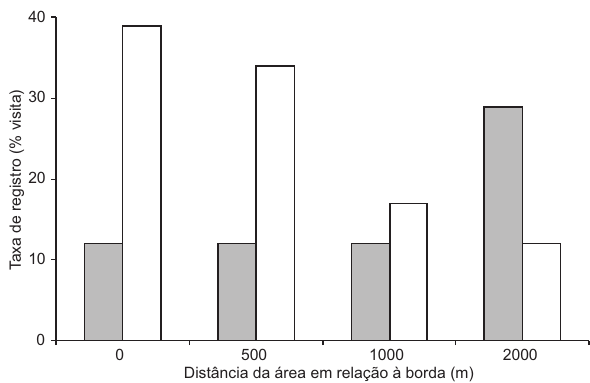
Figura 3. Taxas (%) de registro médio/visita de gralhas (barras cinzas) e cachorros (barras brancas) em relação à distância da borda (m) obtidas durante os censos acústicos e visuais em 2004 na Estação Ecológica de Águas